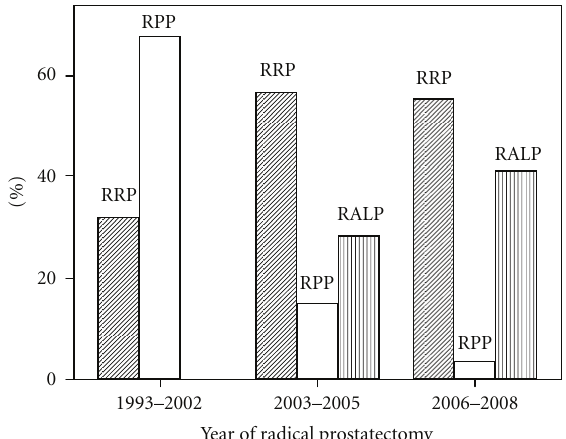
Figure 1: Radical prostatectomies over time at the Duke Prostate Center, Duke University Medical